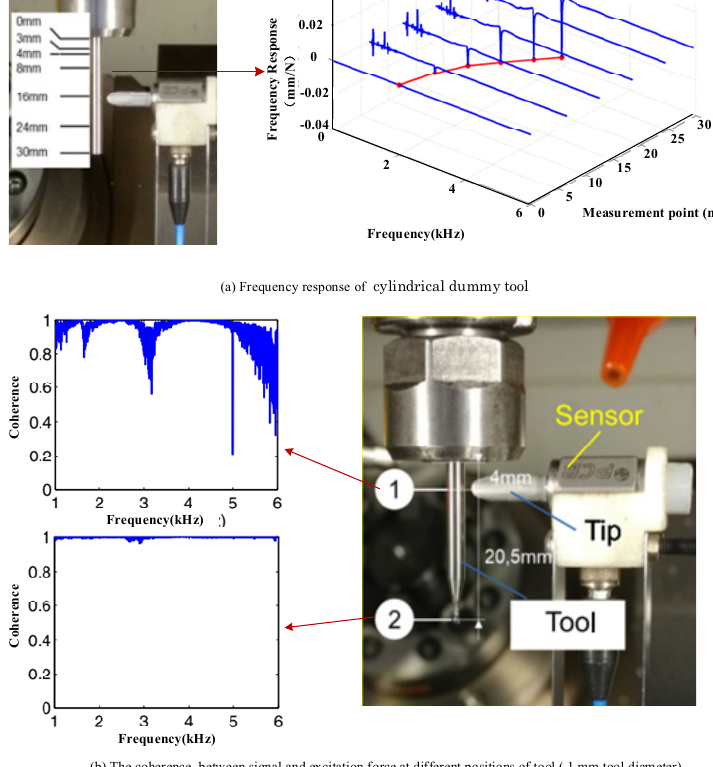
(b) The coherence between signal and excitation force at different positions of tool ( 1 mm tool diameter) Figure 19. Tool vibration responses with different structure